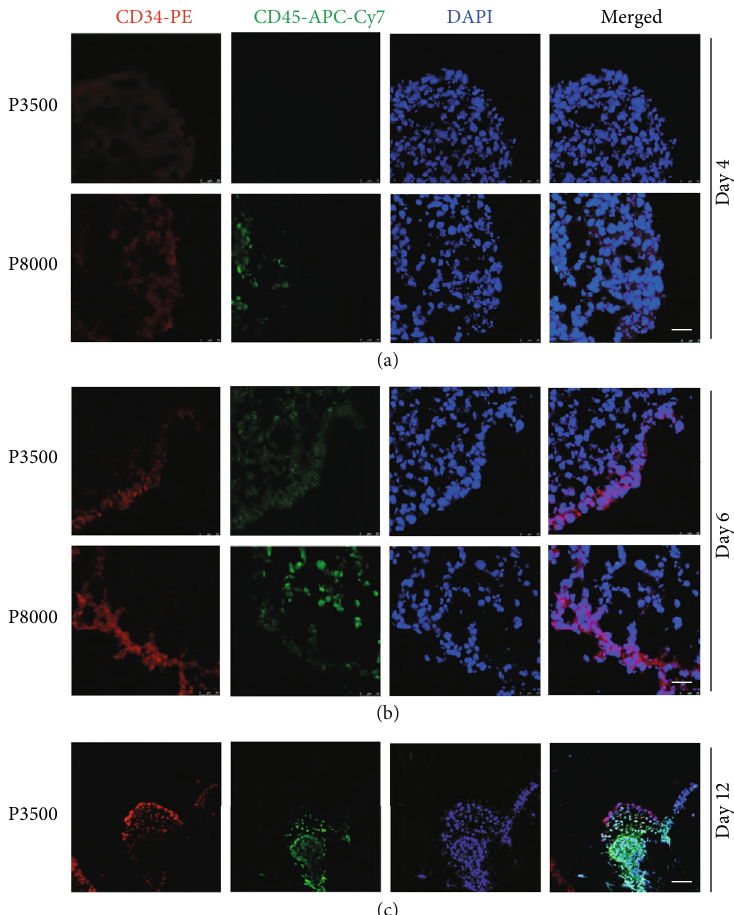
Figure 2: More seeding cells promoted the development of HPCs in EBs. (a – c) Frozen sections and immuno fl uorescence images of EBs in two macrophage di ff erentiation protocols. Immunocytochemical analysis of CD34 (red) and CD45 (green) at day 4, day 6, and day 12. DAPI (blue) shows the cell nuclei (scale bars: 25 μ m in (a) and (b), 50 μ m in